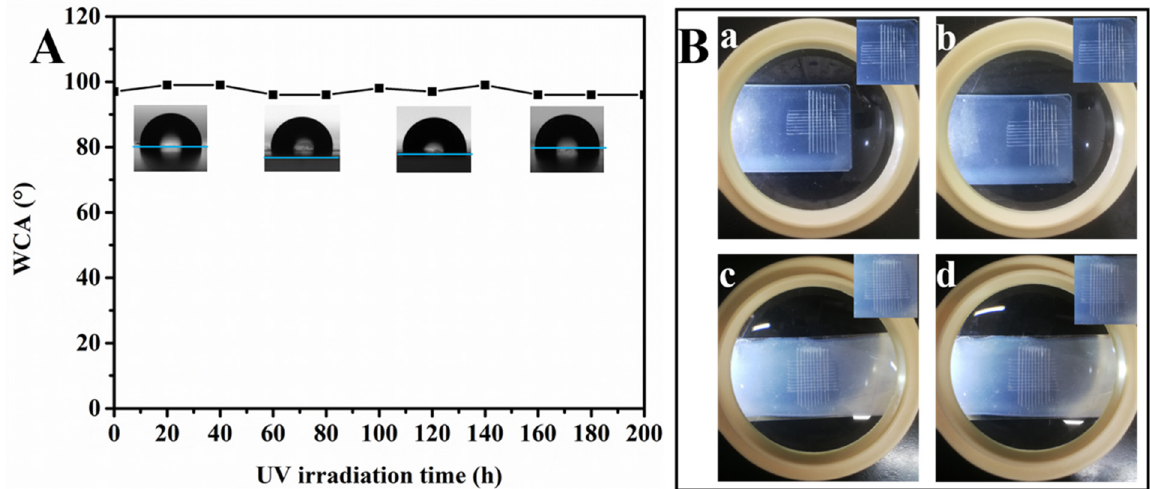
Figure 11. ( A ) WCAs of P(CTFE- alt -IBVE)/MFWPU composite coating under UV irradiation for different amounts of time. ( B ) Adhesion performance determination of the coatings via a cross-cut test: glass-based coating ( a ) and tinplate coating ( c ) before 3M tape application; glass-based coating ( b ) and tinplate coating ( d ) after 3M tape application.